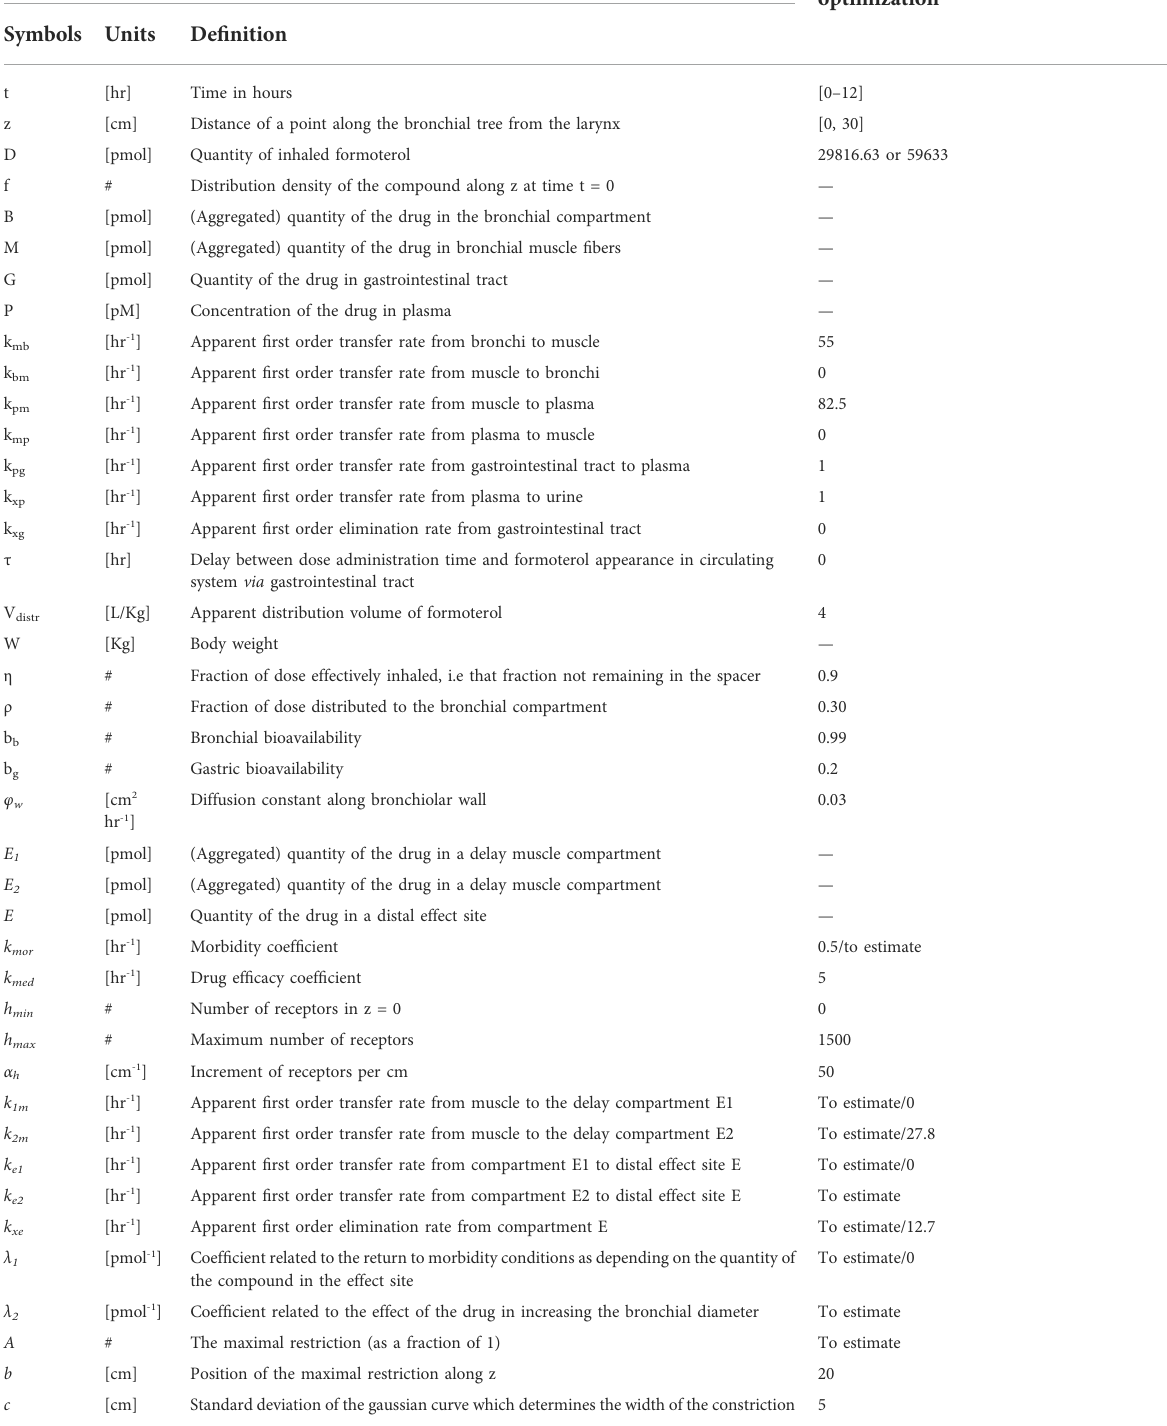
TABLE 3 Model pharmacokinetics and pharmacodynamics variables and parameters. Pharmacokinetics variables/parameters Numerical value fi rst optimization/second